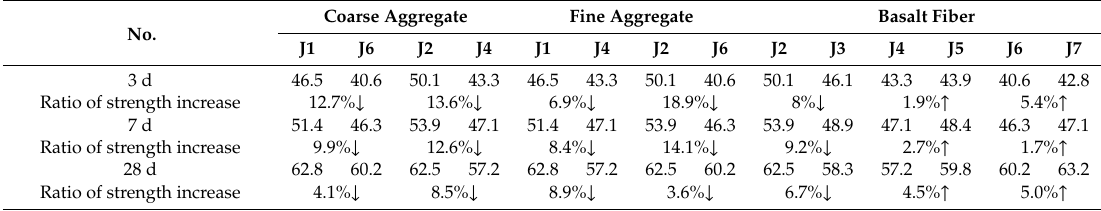
Table 6. Analysis of concrete compressive strength (MPa).